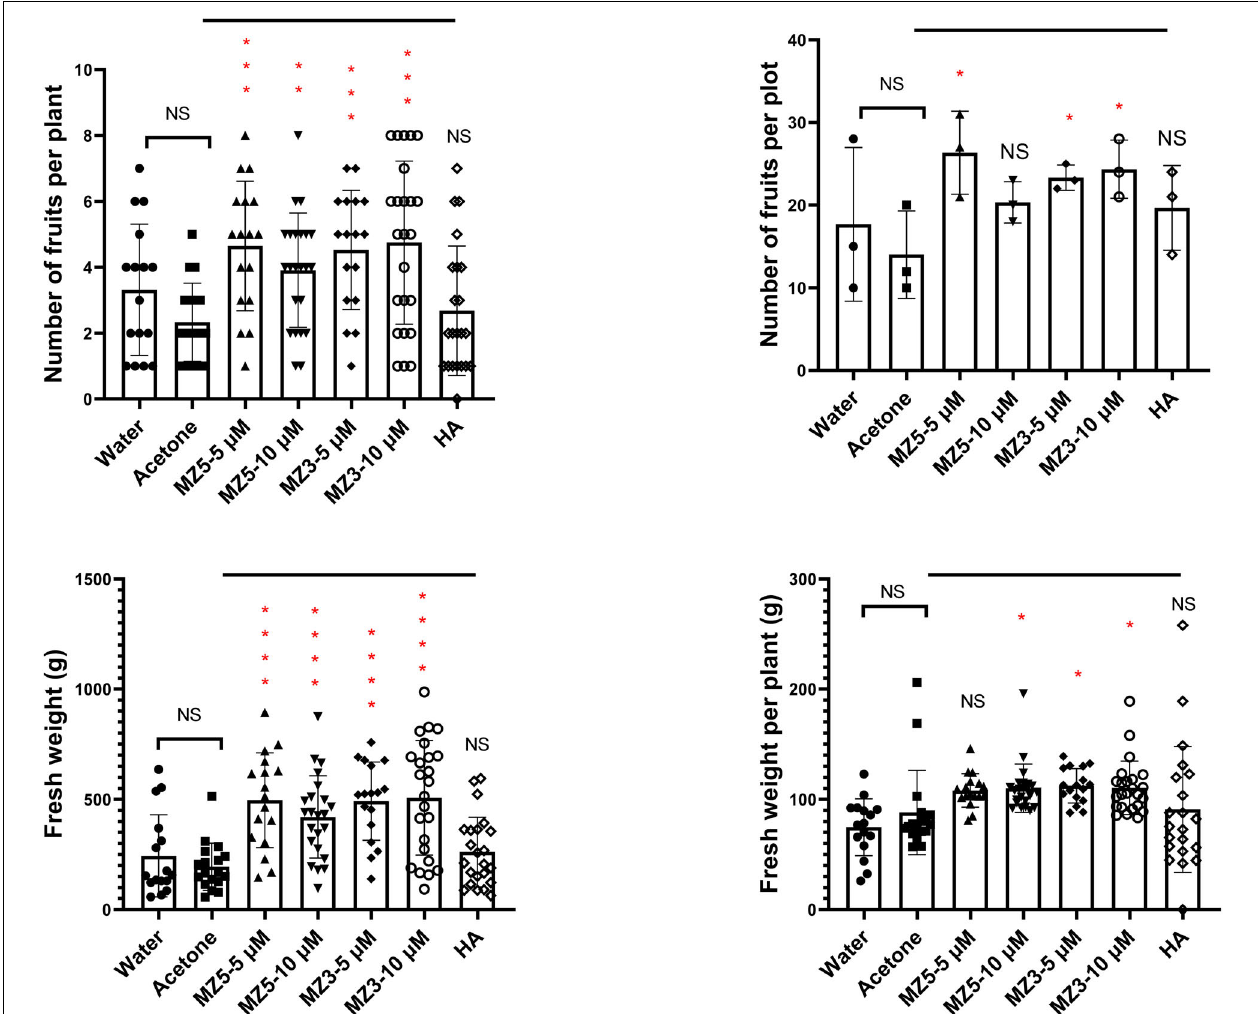
FIGURE 9 | MiZax effect on squash fruit production from the field of the KAU, performed in 2021 ( n ≥ 16). Statistical analysis was performed using the two-tailed Student’s t -test. Asterisks indicate statistically significant differences as compared to CTL (* p < 0.05, ** p < 0.01, *** p < 0.001, **** p < 0.0001). Symbols ( • , CTL; (cid:4) , Acetone; (cid:78) , 5 µ M MZ5; (cid:72) , 10 µ M MZ5; (cid:7) , 5 µ M MZ3;